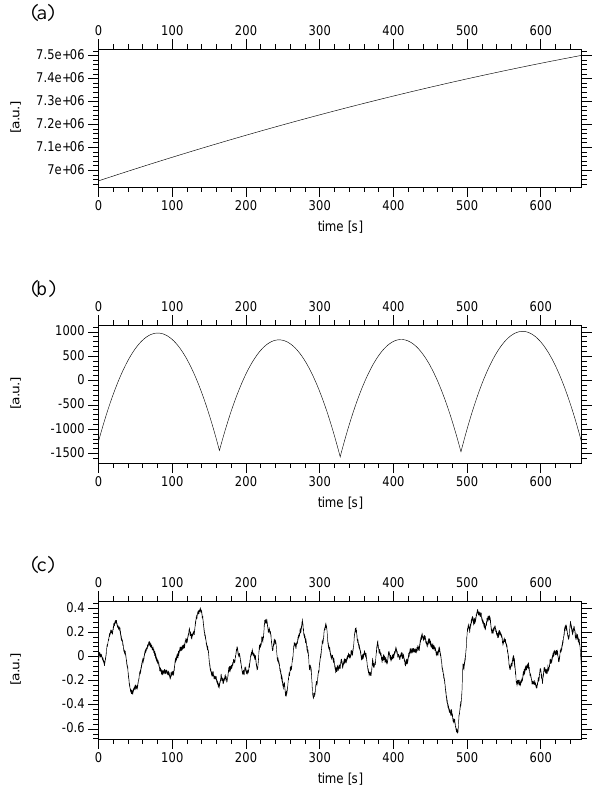
Fig. 2. Trend subtracting; (a) raw data, (b) after removing a local linear trends, (c) after removing a local trend of third